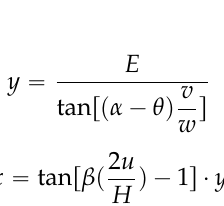
Figure 2. Top view of camera [17].